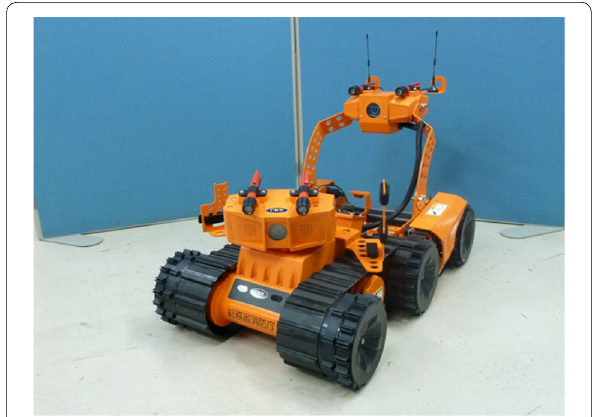
Fig. 4 “FRIGO‑M,” the firefighting reconnaissance robot